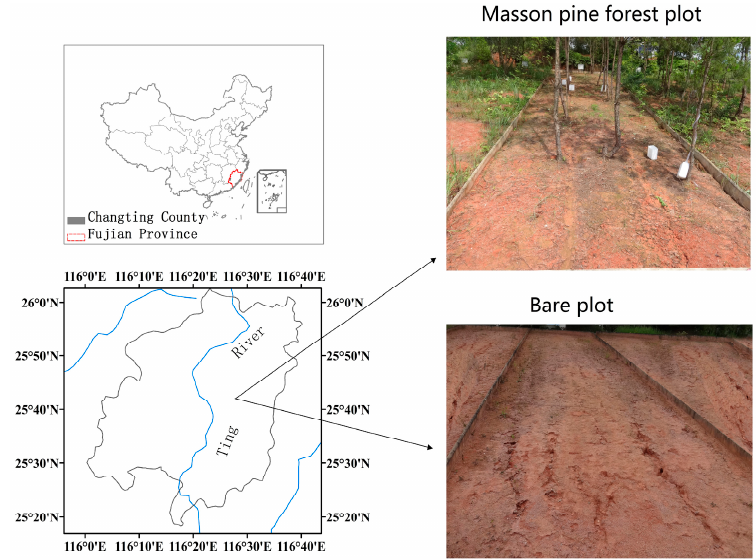
Figure 1. Study site locations and views of the studied plots.